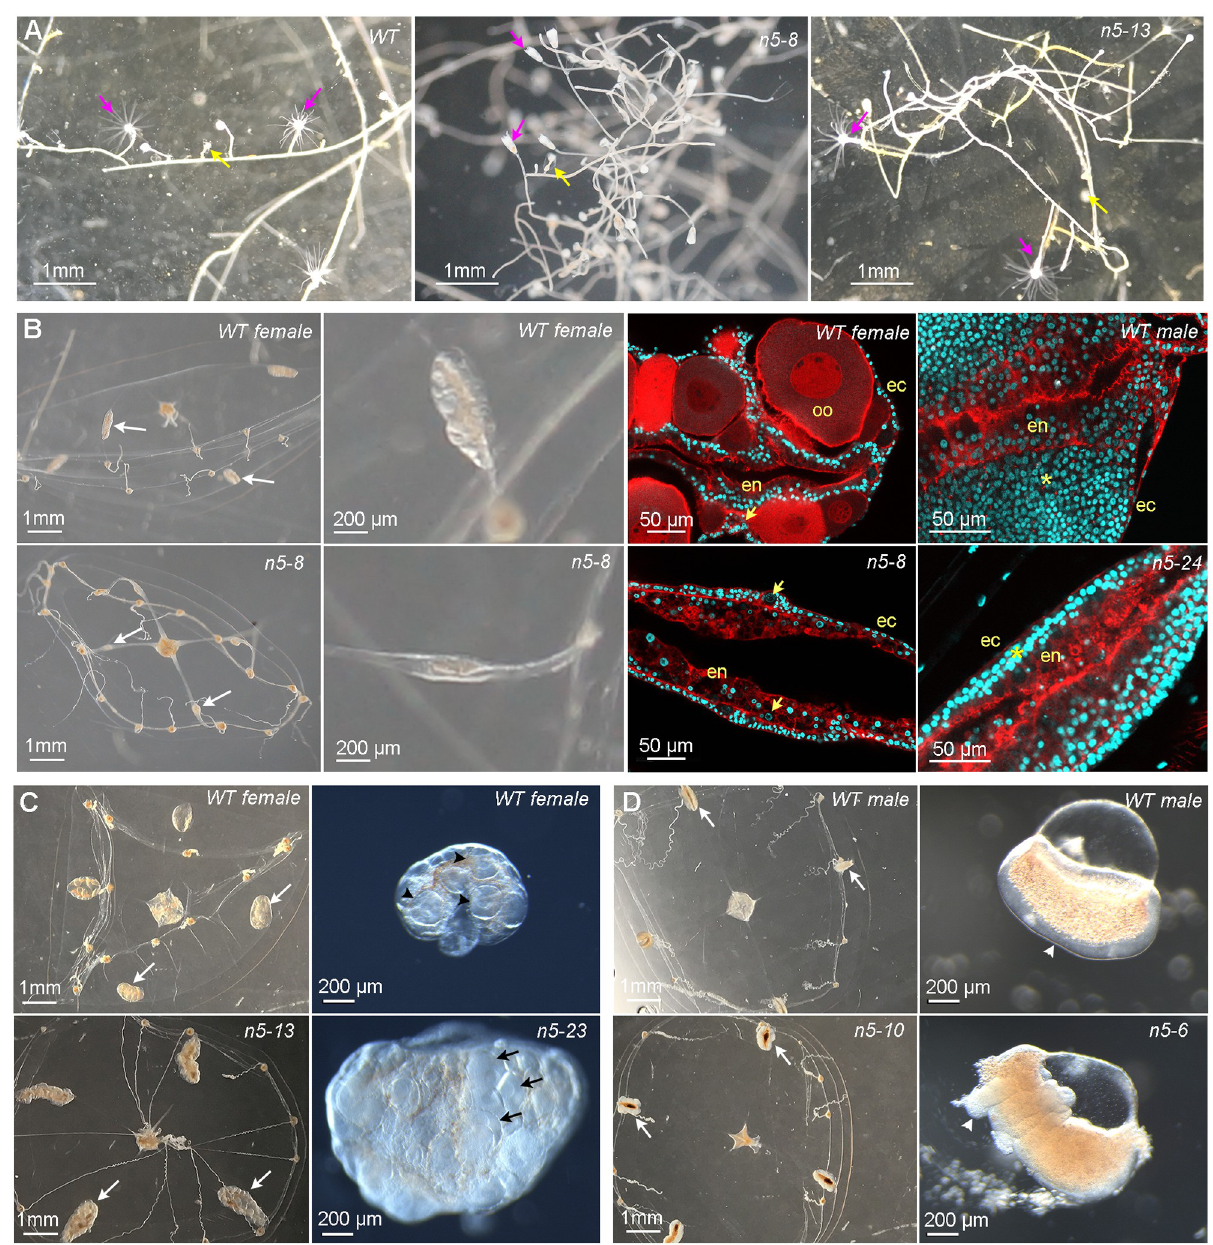
Fig 2. Phenotypes of Clytia MIHR mutants. Light and confocal microscope images of MIHR mutant F0 polyp colonies and jellyfish. (A) Morphology of a wild-type (WT) colony, Z11, and two MIHR mutant colonies (n5-8 and n5-13), as indicated. All MIHR mutant colonies contained gastrozooid and gonozooid polyps (pink and yellow arrows, respectively); however, the connecting stolons in some mutant colonies (see Table 1) were convoluted and frequently detached from the glass substrate, while stolons of WT colonies and the other mutant colonies were straight and adhered tightly. (B) Phenotypes of fully grown WT (top row) and mutant n5-8 or n5-24 (bottom row) jellyfish. Mutant and WT jellyfish show very similar morphology, but gonads developed poorly in these mutants, as shown by white arrows in the first column and at higher magnification in the second column. The third and fourth columns are confocal microscope images through the gonads of adult jellyfish from females and males, respectively; nuclei are stained with Hoechst 33342 (cyan) and F-actin with Phalloidin (red). In the n5-8 female gonad, small oocytes (arrows) can be detected between the endodermal (en) and ectodermal (ec) layers, but no large growing oocytes (oo) are present compared to the WT female gonad. In the n5-24 male gonad, the spermatogenic zone (asterisk) between endoderm and ectoderm is much thinner than in the WT male gonad. (C) Comparison of mutant n5-23 and n5- 13 (bottom row) female medusae gonads (white arrows) swollen by an accumulation of large oocytes to WT (Z11) female medusae (top row). Right panels show gonads dissected from 3-week-old n5-23 medusae 10 hours after a light cue that induced spawning in the WT but not the mutant gonad. Black arrowheads indicate large growing oocytes in the WT gonad and black arrows indicate fully grown oocytes in the mutant gonad. (D) Adult mutant n5-10 and n5-6 male medusa (bottom row) compared to WT (Z13) male medusae (top row) have deformed gonads (white arrows). Right panels show isolated gonads, illustrating the thickened and irregular spermatogenic layer (arrowheads) in the mutant. Scale bars as indicated. MIHR , MIH receptor. https://doi.org/10.1371/journal.pbio.3000614.g002 PLOS Biology | https://doi.org/10.1371/journal.pbio.3000614 March 3,